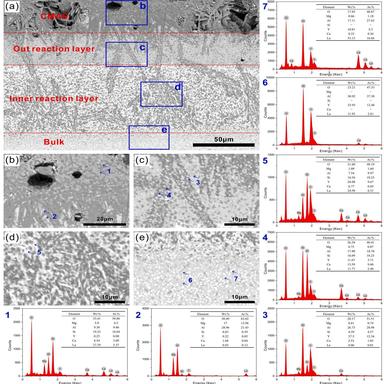
(a) Cross-sectional backscattered electron SEM image of the (Y0.8La0.2)3Al5O12 sample after CMAS corrosion at 1250 ◦C for 5 h, (b) magnified SEM image of region b, (c) magnified SEM image of region c, (d) magnified SEM image of region d, (e) magnified SEM image of region e, EDS analysis detected from (b), (c), (d) and (e) detailed in spectrum 1–7.